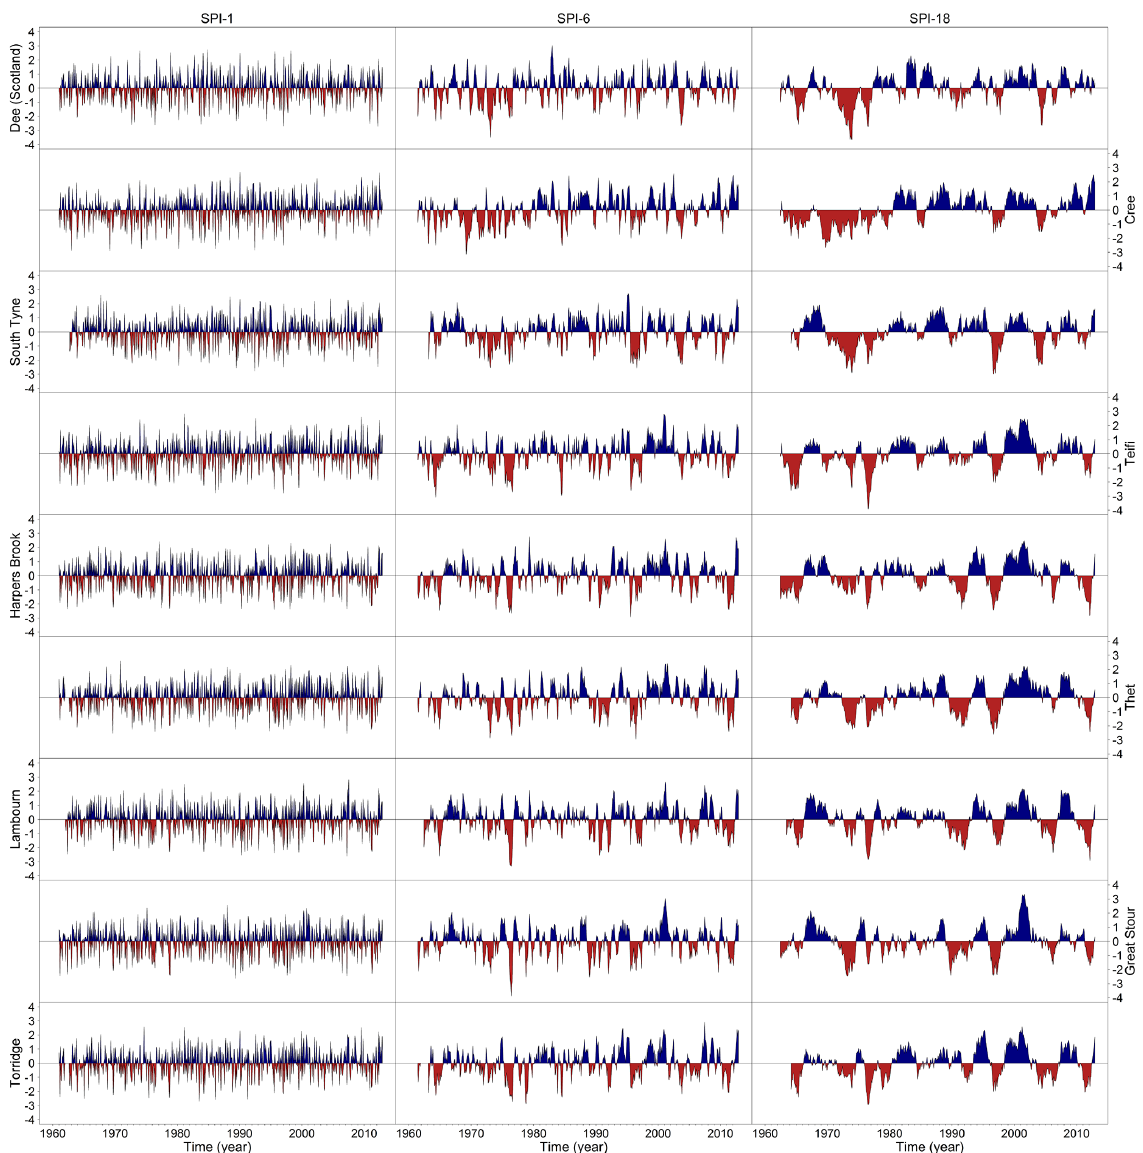
Figure 6. Case study catchment SPI time series for selected accumulation